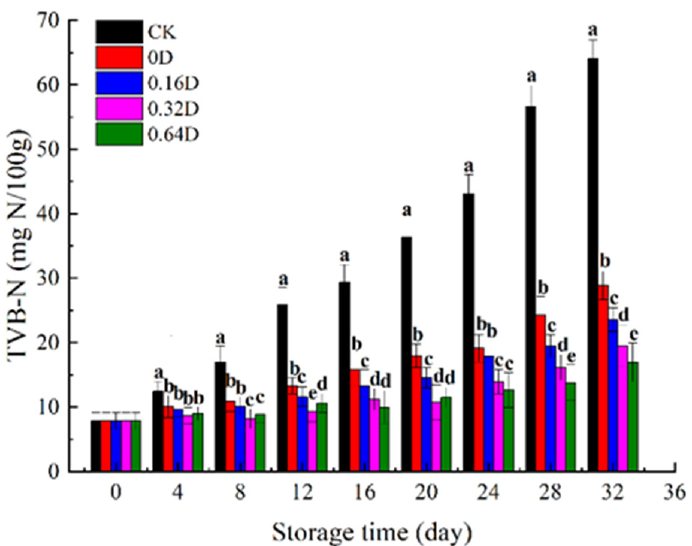
Figure 4. Changes in the TVB-N of turbots during refrigerated storage. Different superscript letters a–e indicate significant differences ( p < 0.05). Different superscript letters a–d indicate significant differences ( p < 0.05) .